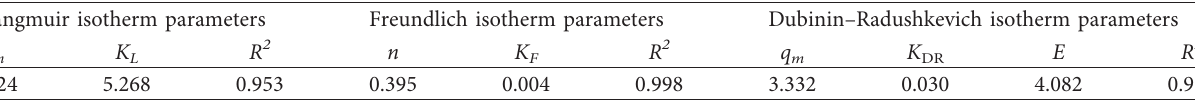
Table 2: Adsorption isotherm constants for MB adsorption onto the sediment.